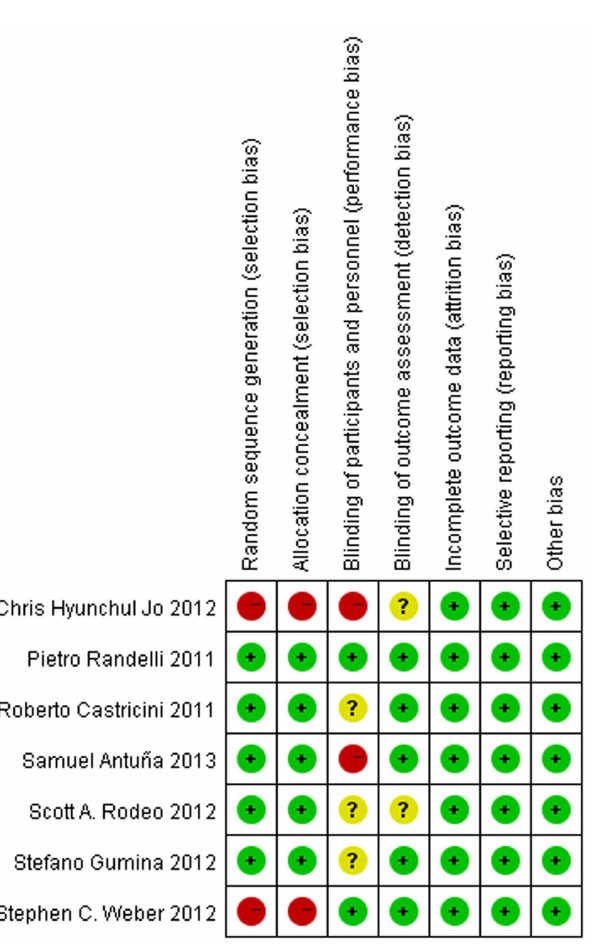
Figure 2. The methodological quality of the included studies.